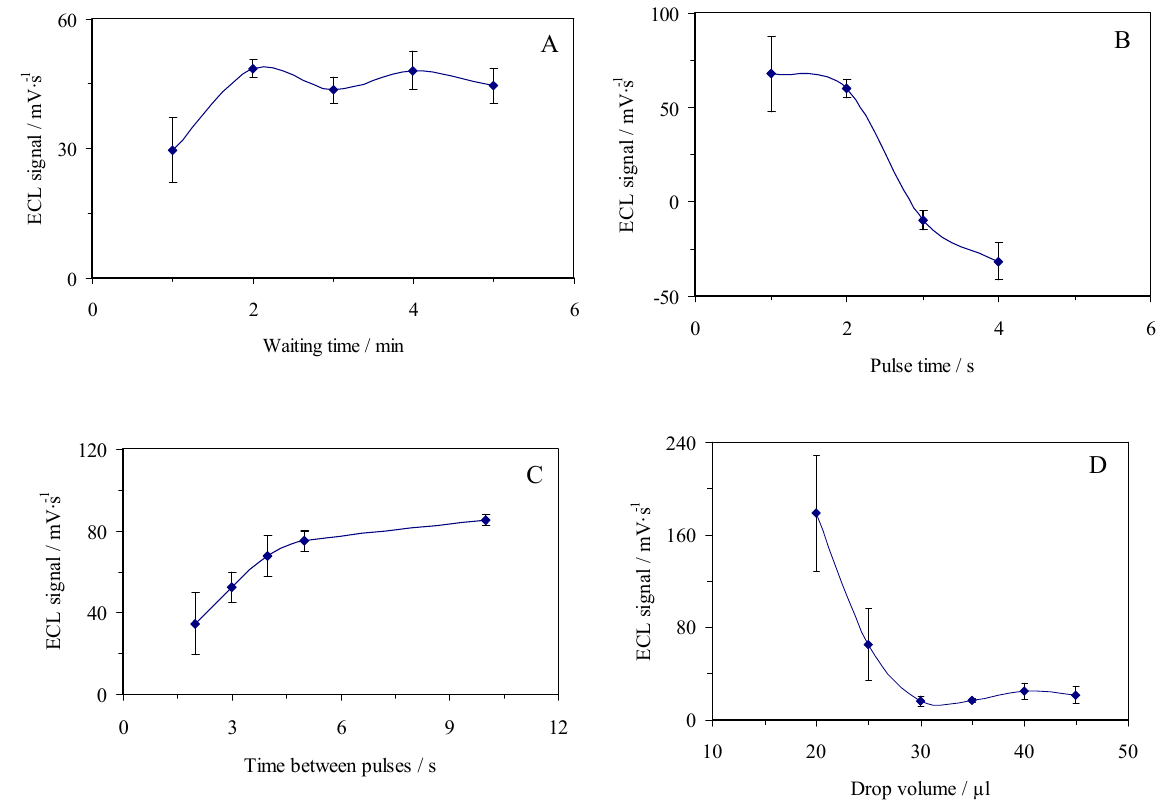
Figure 7. Electrical variables for ECL lactate determination: (A) waiting time; (B) pulse time; (C) time between pulses; and (D) drop